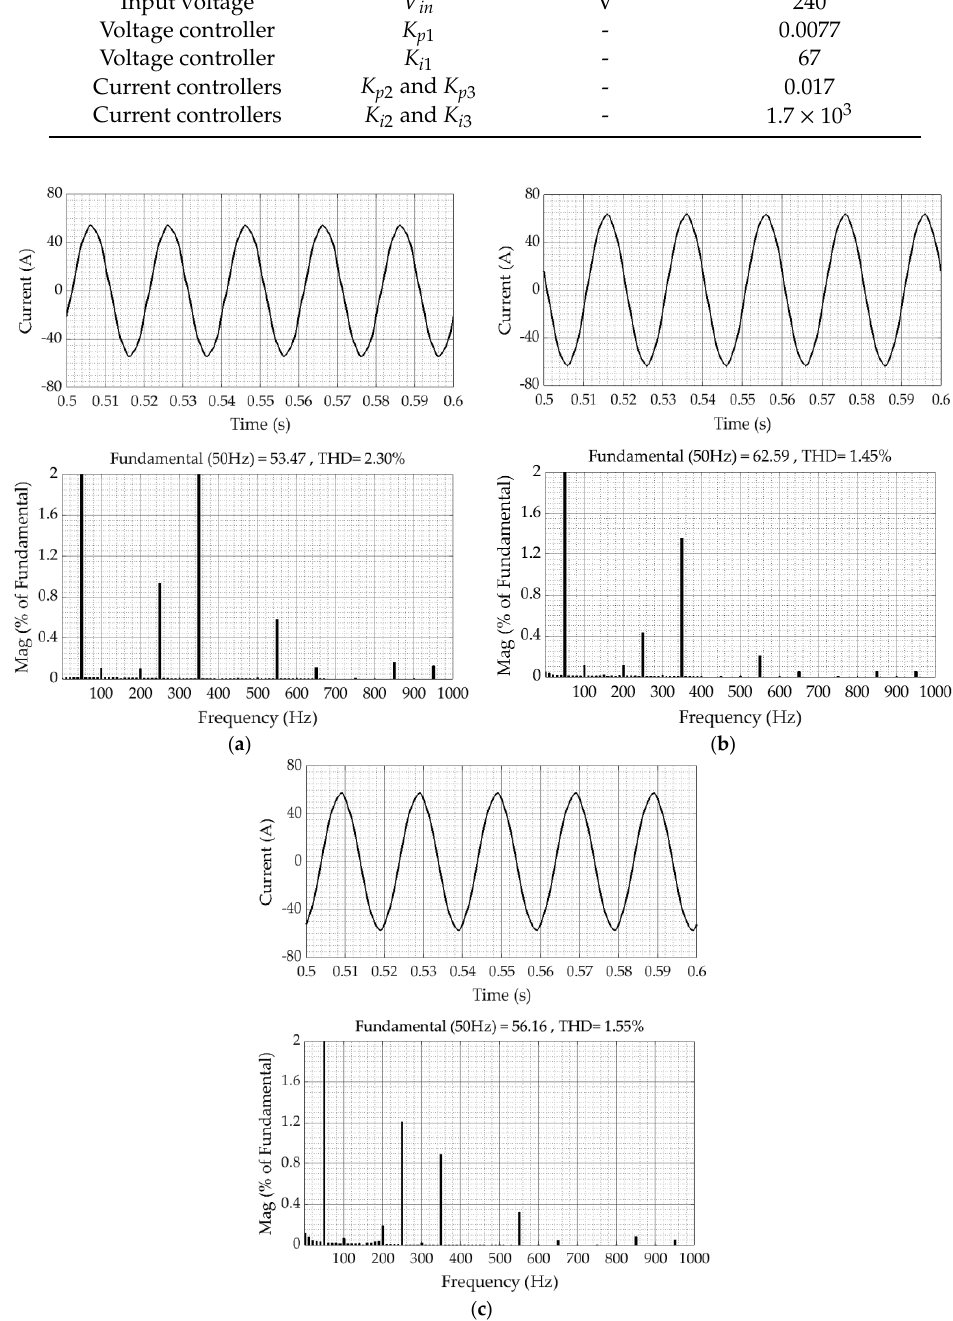
Figure 10. The output current of the charger for Level 2 charging: ( a ) Phase A, ( b ) Phase B, and ( c ) Phase C.